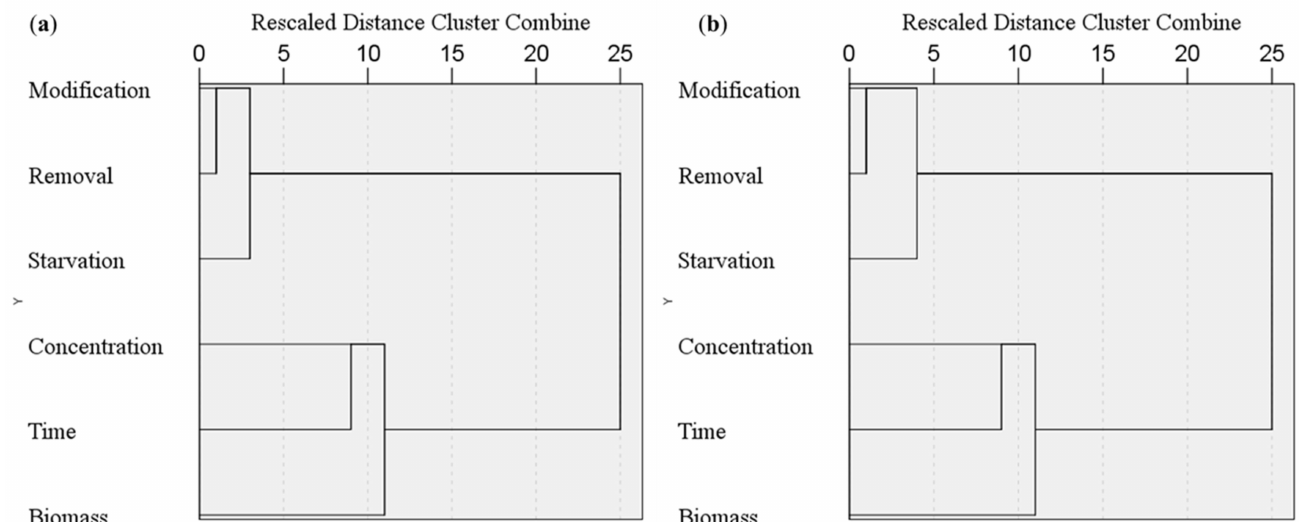
Figure 5. Cluster analysis using the between-group linkage clustering method with Squared Eu- clidean distance interval measured on the applied treatments for ( a ) phenol and ( b ) 2-chlorophenol removal by C. vulgaris dried biomass. Biomass = algal dried biomass per liter, Time = duration for treatments, Concentration = concentration of contaminants, Modification = chemical/acid modifi- cation of dried biomass, Starvation = Phosphorus starvation by which biomass is produced, and Removal = Phenol/2-chlorophenol